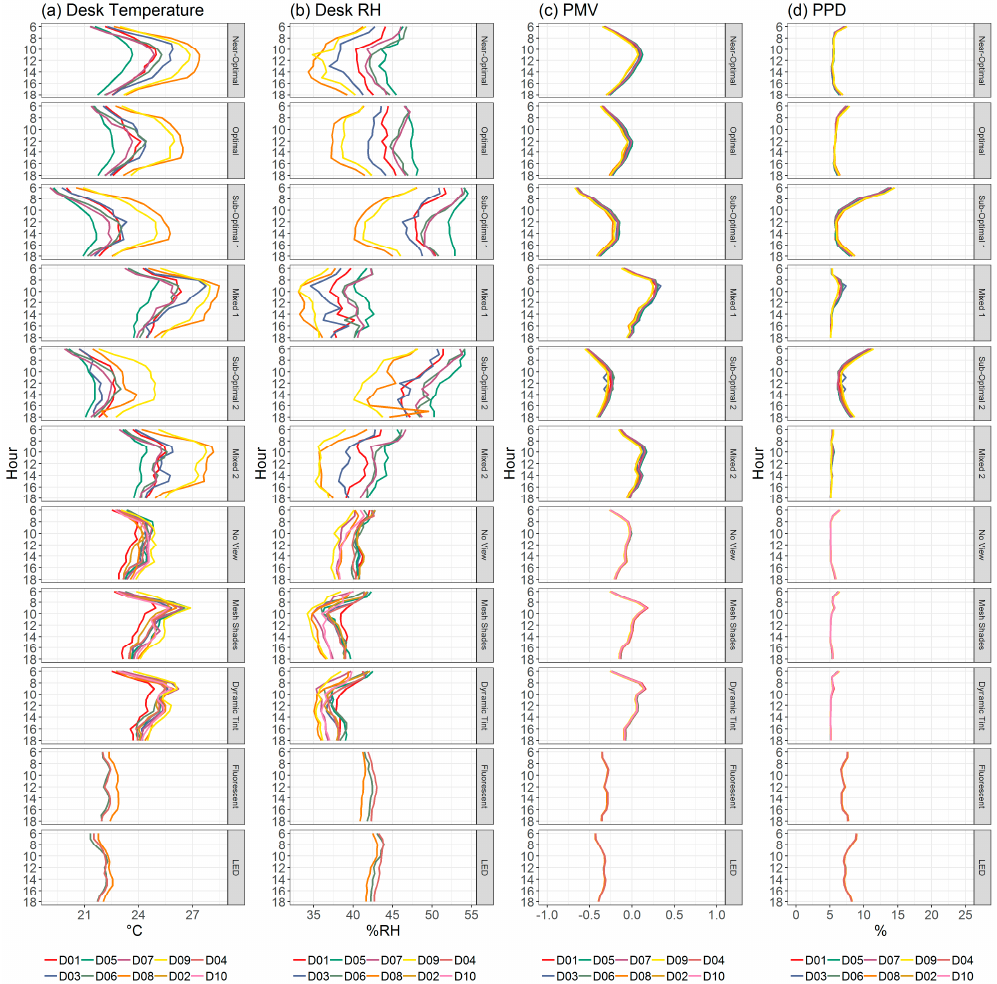
Figure 4. Hourly medians depicting spatial variability of ( a ) desk temperature ( ◦ C) and ( b ) desk relative humidity (RH) (%RH), ( c ) predicted mean value (PMV), and ( d ) predicted percentage dissatisfied (PPD) during each experimental condition of three office experiments.